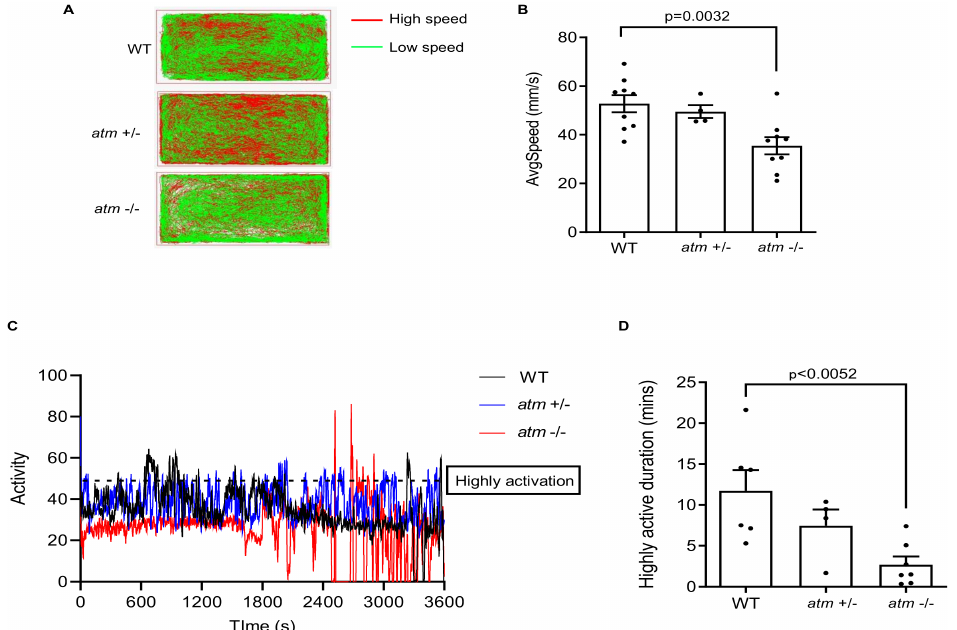
Figure 2. Behavior test of atm − / − zebrafish. ( A ) Trajectory diagram of 6-month-old WT, atm +/ − and atm − / − zebrafish in 60-minue open-field tracking test. ( B ) Average speed of 6 months old WT, atm+/ − , and atm − / − zebrafish in A (n = 9 for WT and atm − / − ; n = 4 for atm+/- ). ( C ) Activity diagram of WT, atm +/ − , and atm − / − zebrafish in 60-minues open-field quantification test. ( D ) Highly activation duration of WT, atm +/ − , and atm − / − zebrafish (n = 6 for WT; n = 7 for atm − / − ; n = 4 for atm+/ − ). The statistical significance was analyzed using one-way ANOVA. Data are shown as means ±